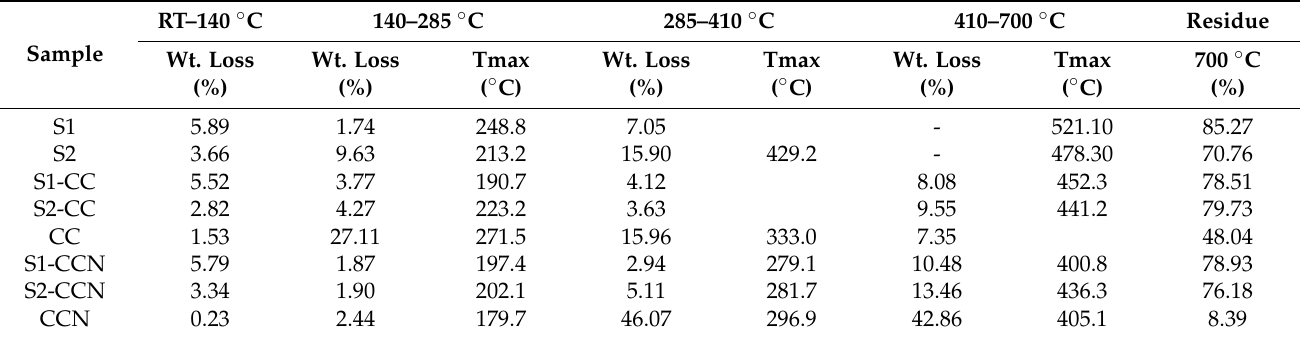
Table 3. Characteristic decomposition temperatures and mass losses of hybrid materials and cur- cumin dyes.